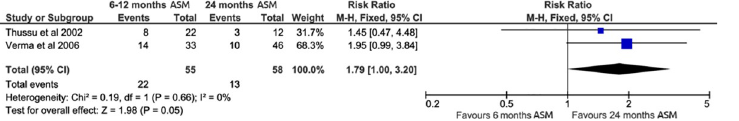
Fig 7. Forest plot of sub-group (patients, where cysts calcified). 6 months ASM versus 24 months ASM. Outcome: seizure recurrence.